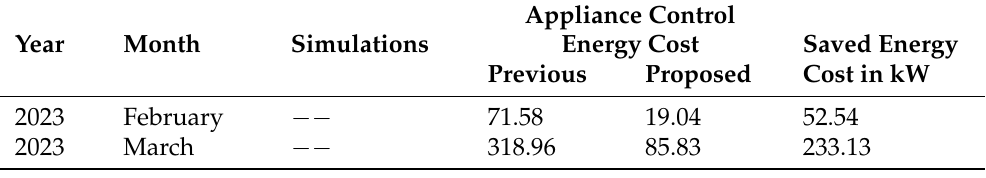
Table 12. Month-wise energy cost-comparison for dataset [12]/Table 6.